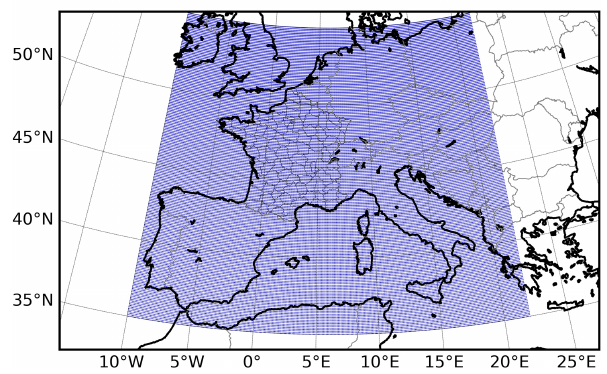
Figure 3. The computation